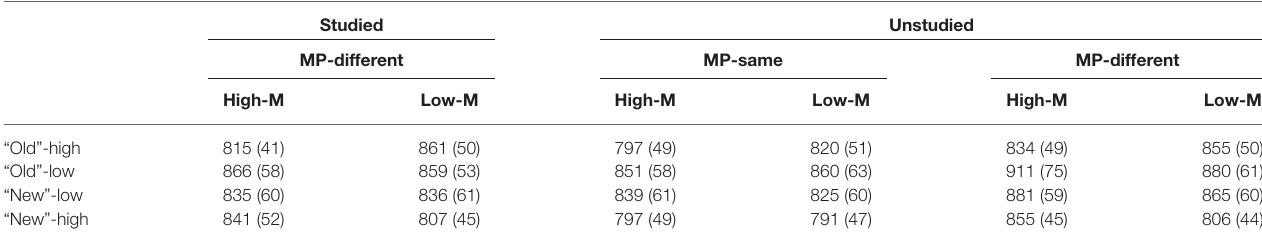
TABLE 1 | Mean RT (ms) in each condition.